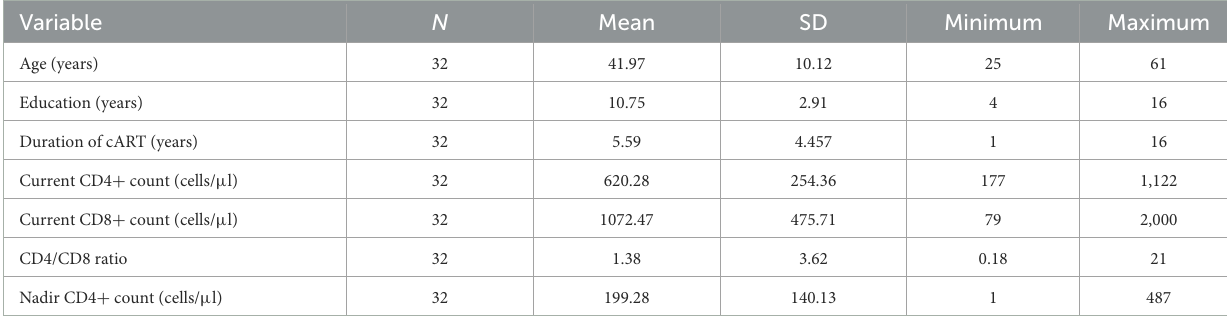
TABLE 1 Clinical and demographic characteristics of the study